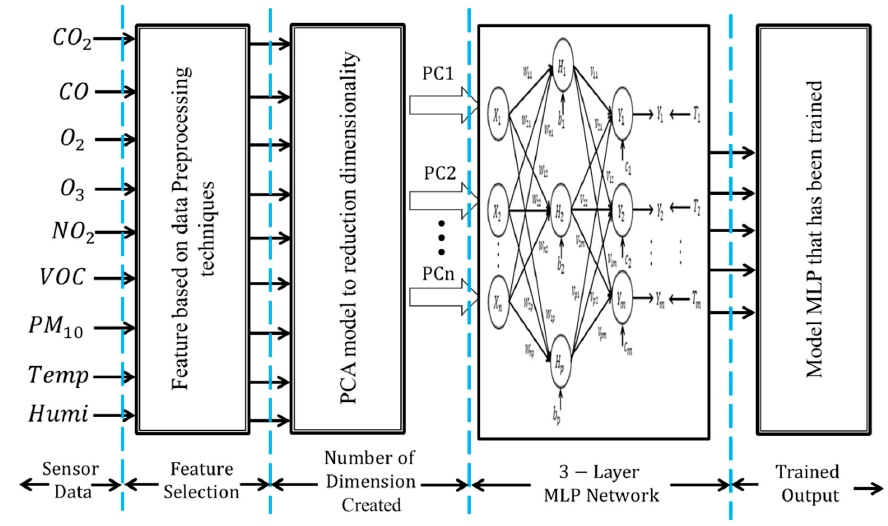
Figure 7. Network architecture of the multilayer perceptron (MLP) model.